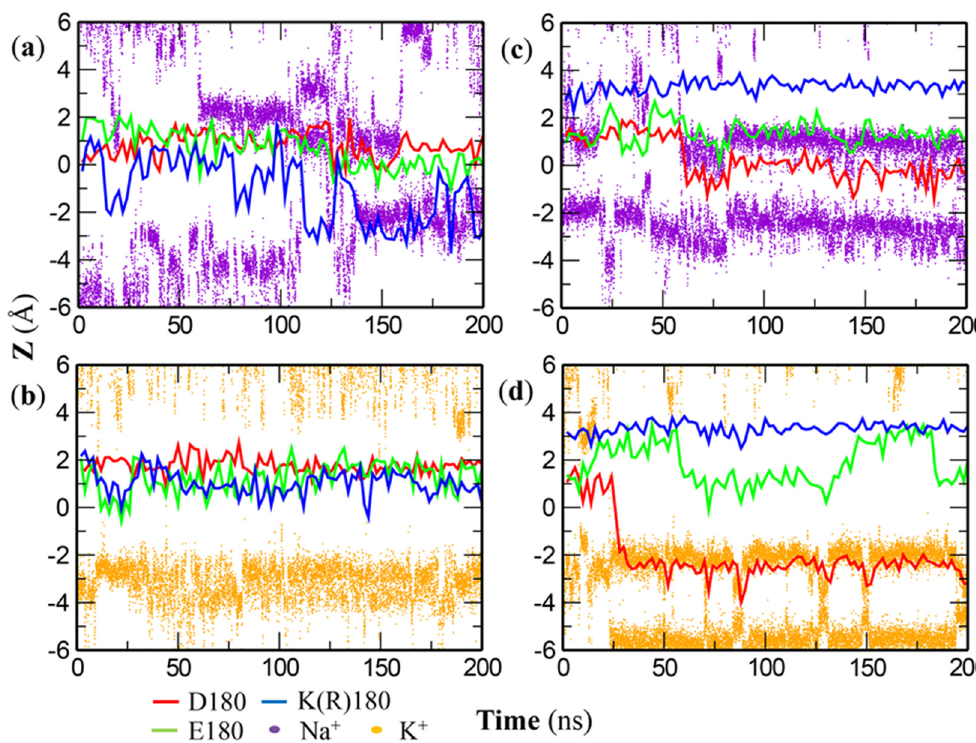
Fig 4. Time-dependent ion occupancy in the SF of the DEKA (a, b) and DERA (c, d) mutants of Na v Rh for Na + (a, c) and K + (b, d) ions in the a-system (IDs 13 – 16 in Table B in S1 File). The vertical axis is the relative distance of the cation to the geometric center of the SF along the z-axis. Violet and orange dots are used to represent the vertical positions of Na + and K + ions respectively. The red and green lines reflect the center of carboxylate oxygen atoms of Asp180 and Glu180 respectively. The blue line describes the position of the side- chain ζ -nitrogen (NZ) atom of Lys180 ( a , b ) or the ζ -carbon (CZ) atom of Arg180 ( b , d